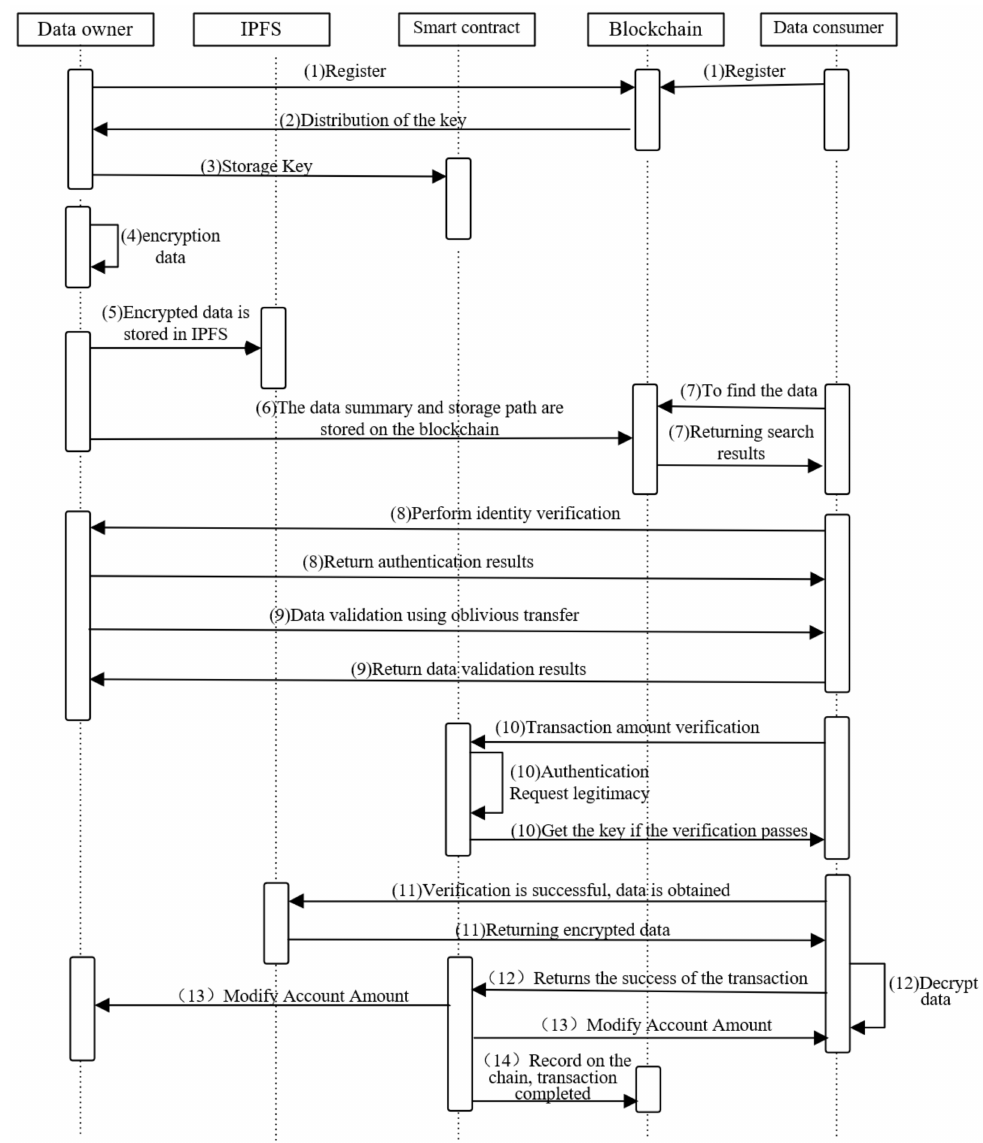
Figure 4. Time sequence diagram of decentralized data